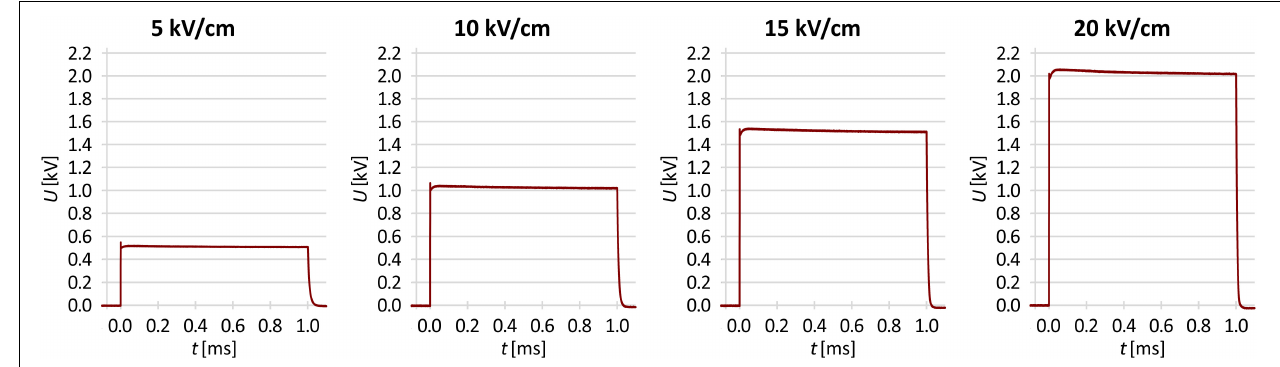
FIGURE 1 | The actual time courses of the voltage delivered in this study by the 5, 10, 15, and 20 kV/cm